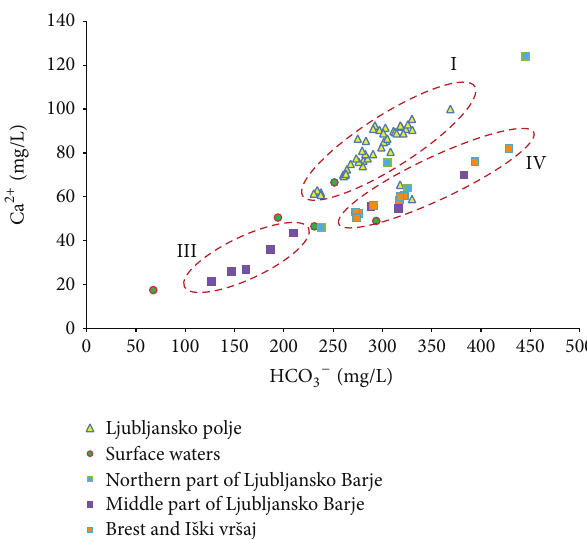
Figure 4: Relationship between Ca 2+ and Mg 2+ in groundwater of Ljubljansko polje and Ljubljansko Barje